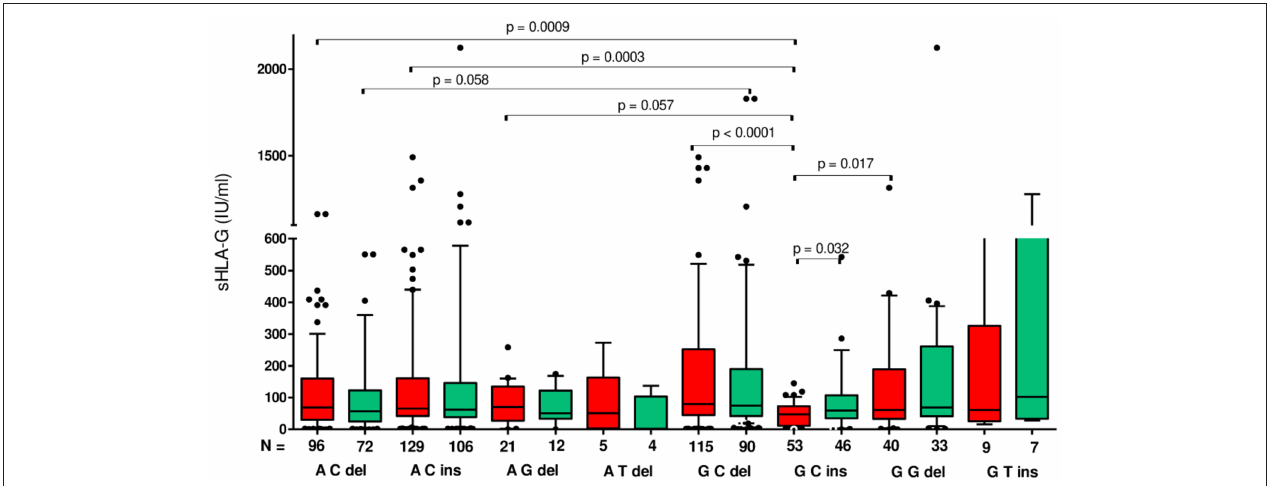
FIGURE 2 | Concentration of soluble HLA-G per milliliter of plasma (IU/ml) measured before and after embryo transfer in all patients according to HLA-G haplotypes. Haplotypes were estimated in the following order: rs1632947: − 964G > A; rs1233334: − 725G > C/T; rs371194629:insATTTGTTCATGCCT/del. Red boxes represent the level of sHLA-G measured before embryo transfer and green boxes, after embryo transfer. Boxes are drawn from the first quartile (25th Percentile) to the third quartile (75th Percentile). Black lines in boxes are medians. Whiskers represent 10–90 percentiles. N is the number of patients. p -values are calculated by Mann–Whitney test.